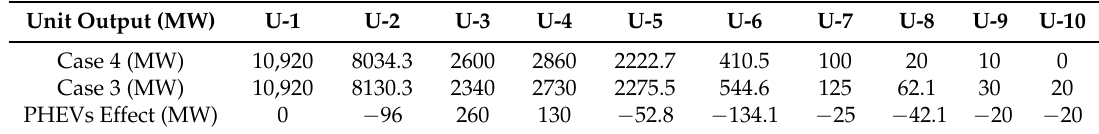
Figure 2. The effect of plug-in hybrid electric vehicles (PHEVs) on the spinning reserve of a smart grid. Table 1. Power from generating units during 24 h considering PHEVs.